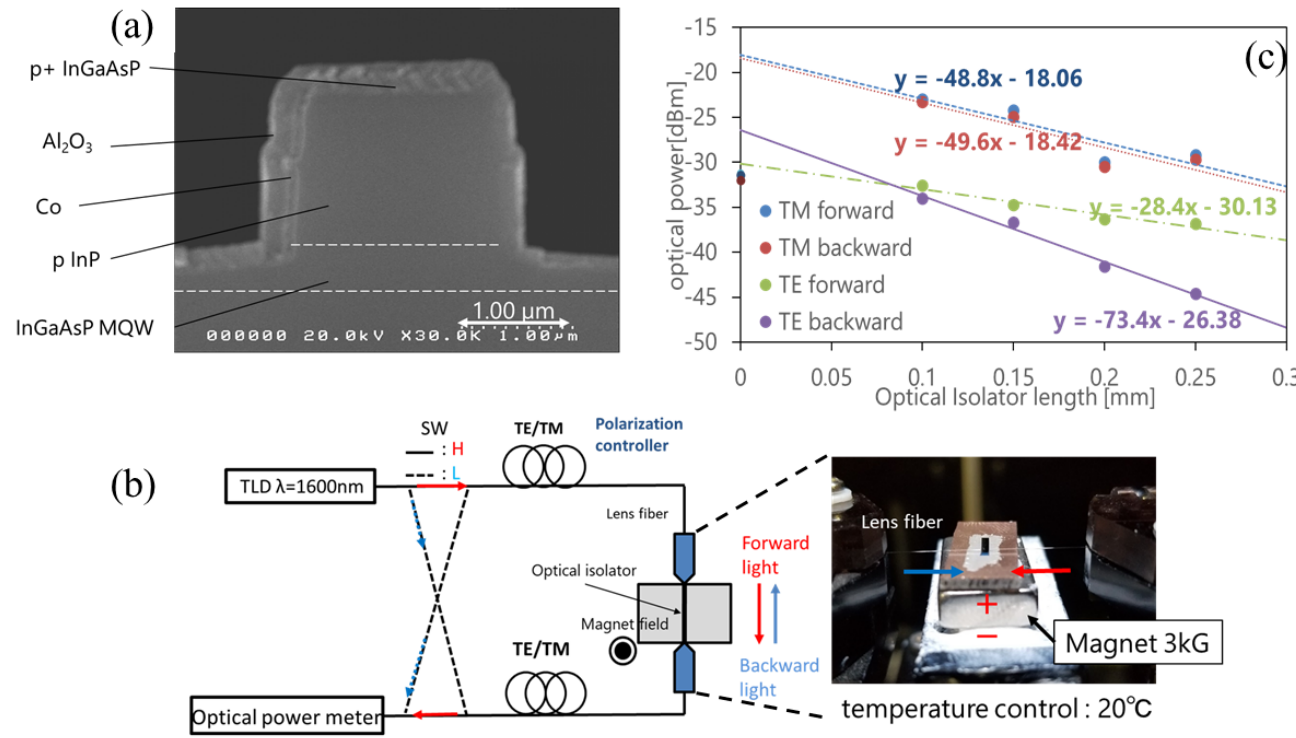
Figure 4. ( a ) A cross-sectional SEM image of the TE mode semiconductor optical isolator. ( b ) A schematic diagram of the experimental setup for measuring the characteristics of semiconductor optical isolators. ( c ) Forward and backward propagation loss as a function of the length of the semiconductor optical